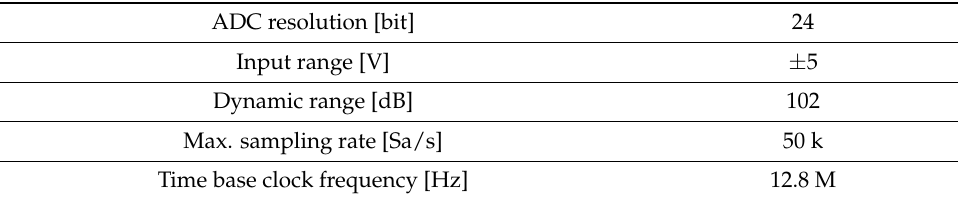
Table 2. Selected technical parameters of the NI-9233 DAQ module.